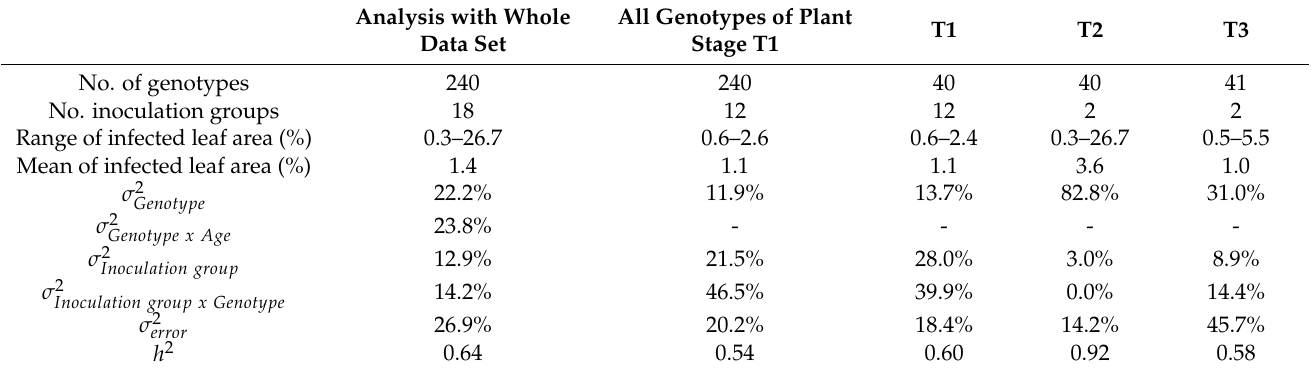
Table 4. Variance components analysis, estimation of heritability ( h 2 ), and distribution of analyzed infected leaf area based on greenhouse data. Analysis was performed observing different scenarios, examining the whole data set including information of all plant developmental stages (Analysis with whole data set) in contrast to single analysis of each stage. The full genotype set (n= 240) at plant stage T1 (All genotypes at plant stage T1) was examined, as well as a limited set of 40 genotypes at the plant stages of 10 days (EC 12; T1), 5 weeks (EC 19; T2), and 10 weeks (EC 25; T3). Distribution of leaf rust resistance for different sets are given by mean value and range of infected leaf